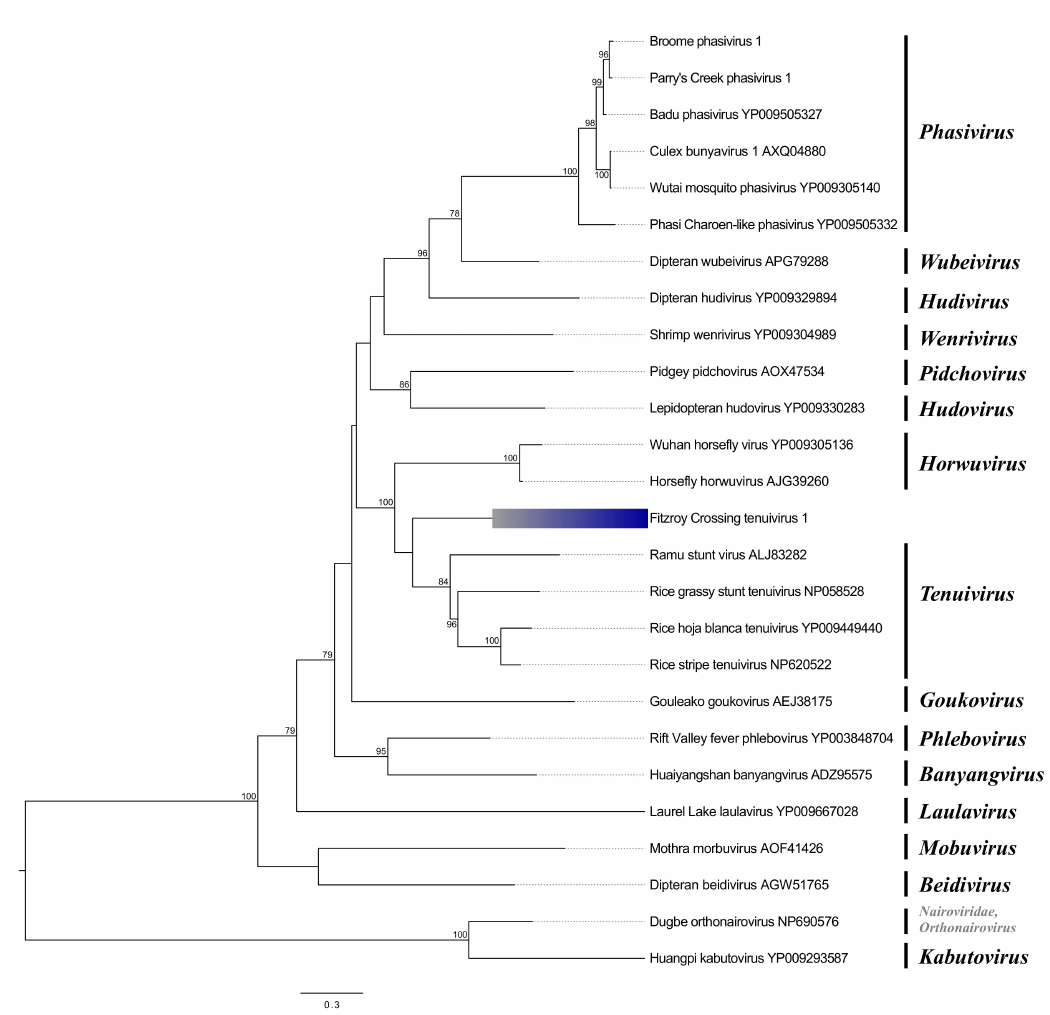
Figure 3. Phylogenetic analysis of phenuiviruses. The maximum likelihood tree was constructed using RdRp protein sequences. The scale bar represents units of substitutions per site and bootstrap support values are displayed when greater than 70%. Viruses identified in this study are highlighted in